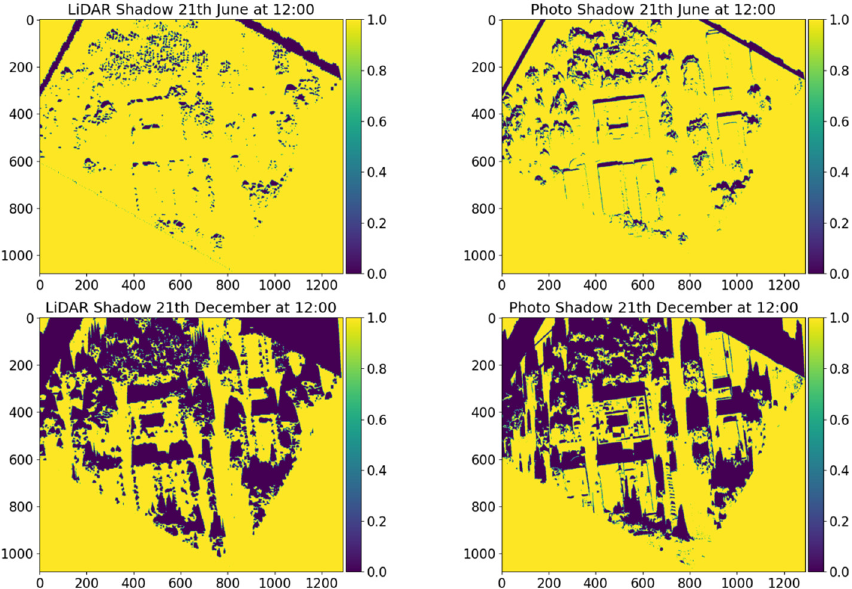
Figure 5. Shadow patterns for 21st June at 12:00 UTC and 21st December at 12:00 UTC.